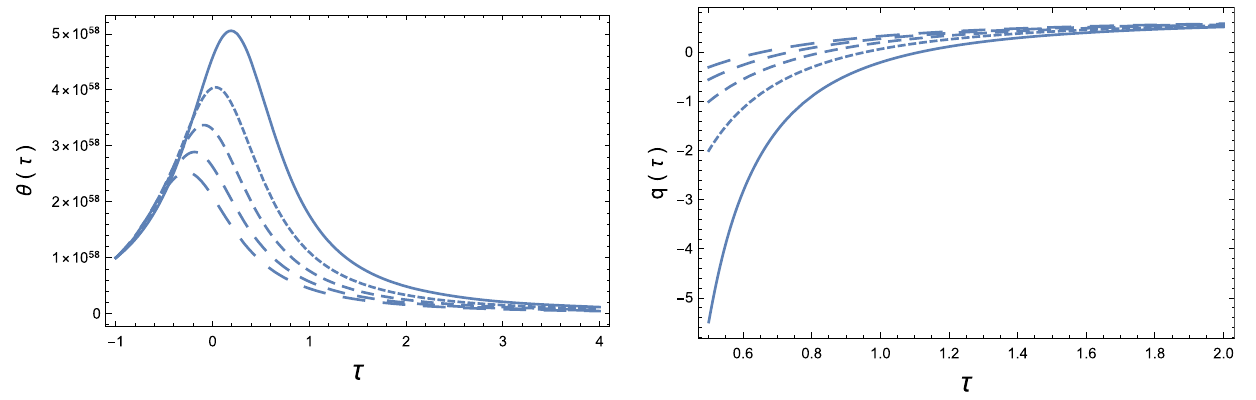
Fig. 10 Time evolution of the dimensionless temperature θ (left fig- ure) and of the deceleration parameter q (right figure) in a loop quantum cosmological Universe filled with a deformed photon gas satisfying the dispersion relation E = kc ( 1 − α k ) , for different values of the param- eter A 4 : A 4 = 4 × 10 − 58 (solid curve), A 4 = 5 × 10 − 58 (dotted